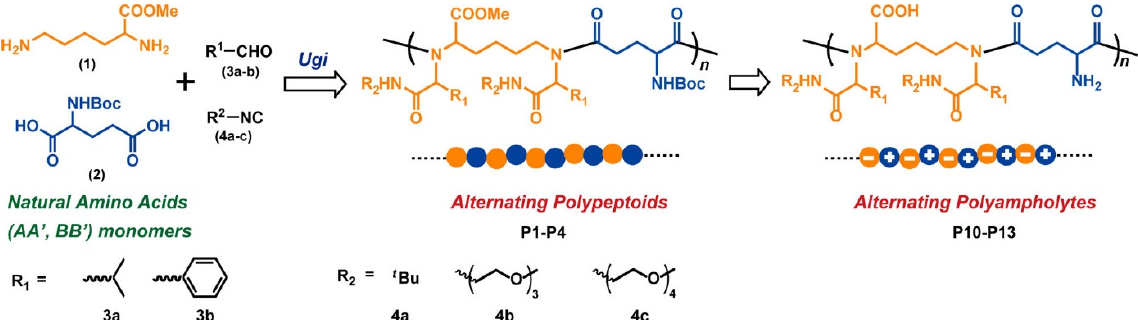
Figure 20. Synthesis of alternating polypeptoids and alternating polyamholytes via Ugi reaction of natural amino acids (Adapted from ref. [112]. Copyright 2018, American Chemical Society).